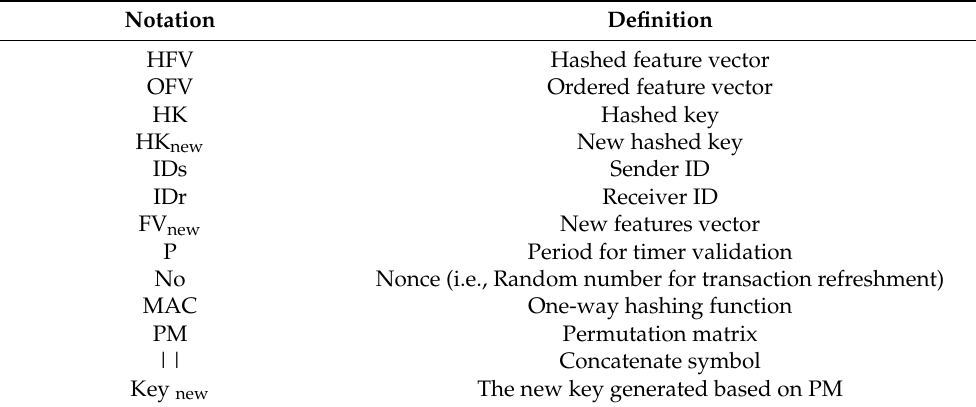
Table 1. The proposed algorithm notations identifications.